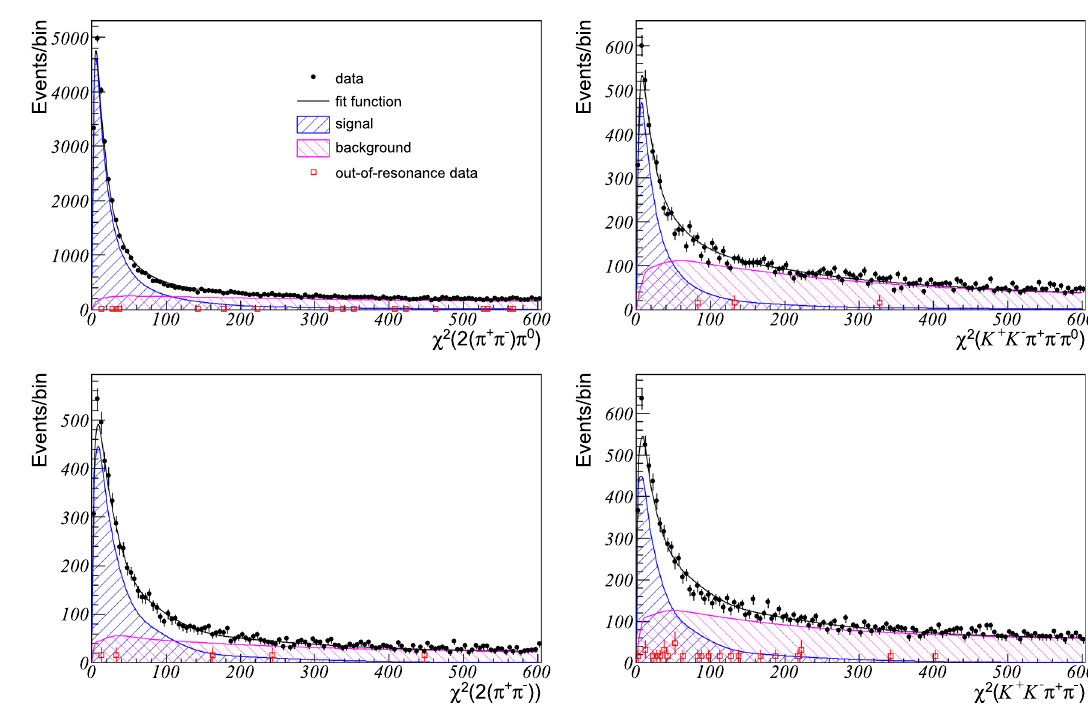
Fig. 1 Distributions of χ 2 from kinematic fits for 2( π + π − )π 0 , K + K − π + π − π 0 ,2( π + π − ) and K + K − π + π − selectedcandidateevents. Black dots are experimental data collected at the J /ψ peak, red squares are data collected in the continuum and normalized as described in the